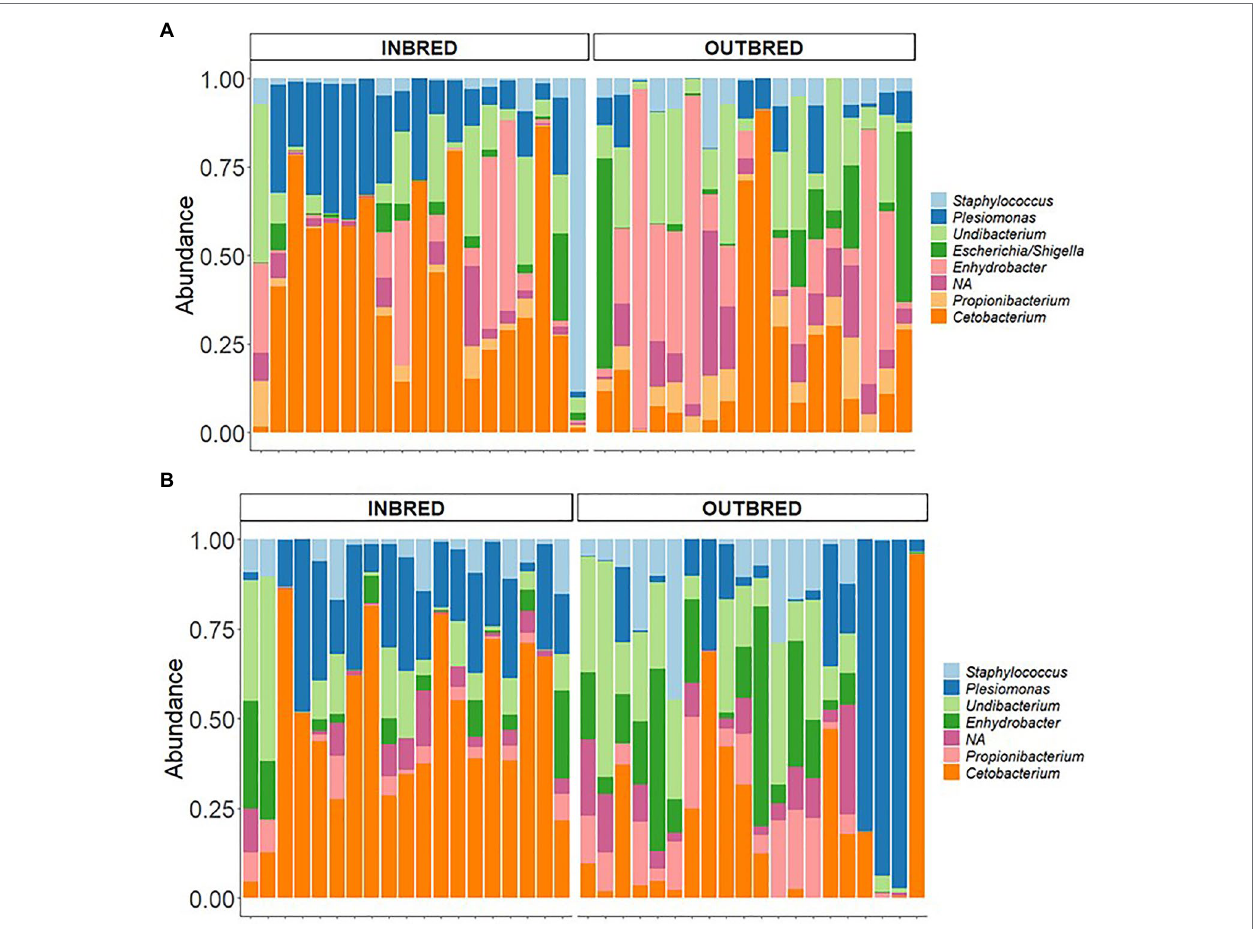
FIGURE 7 | Core microbiota in the anterior and posterior intestine of the inbred and outbred groups of Nile tilapia. (A) anterior intestine and (B) posterior intestine. NA: at the order level is classified as Actinomycetales